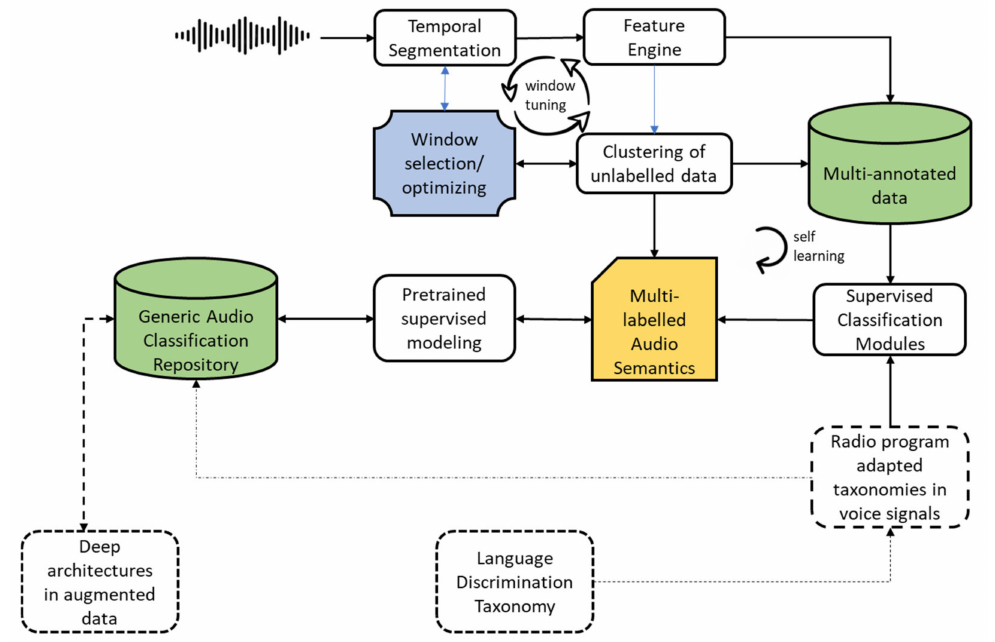
Figure 1. Block diagram of the proposed